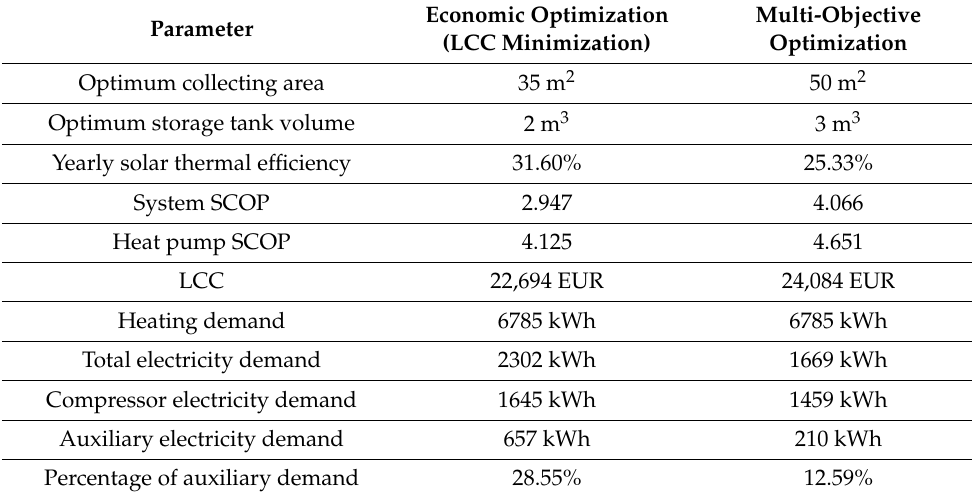
Table 1. Summary of the results for the optimum designs.